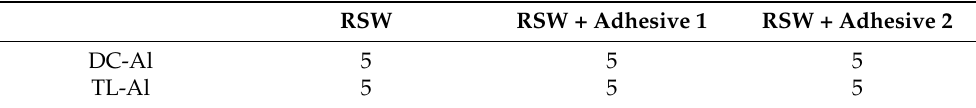
Figure 1. Dimensions of the test joint. Table 3. Number of joints made by resistance spot welding (RSW) and hybrid RSW and adhesive bonding (AB) technology.